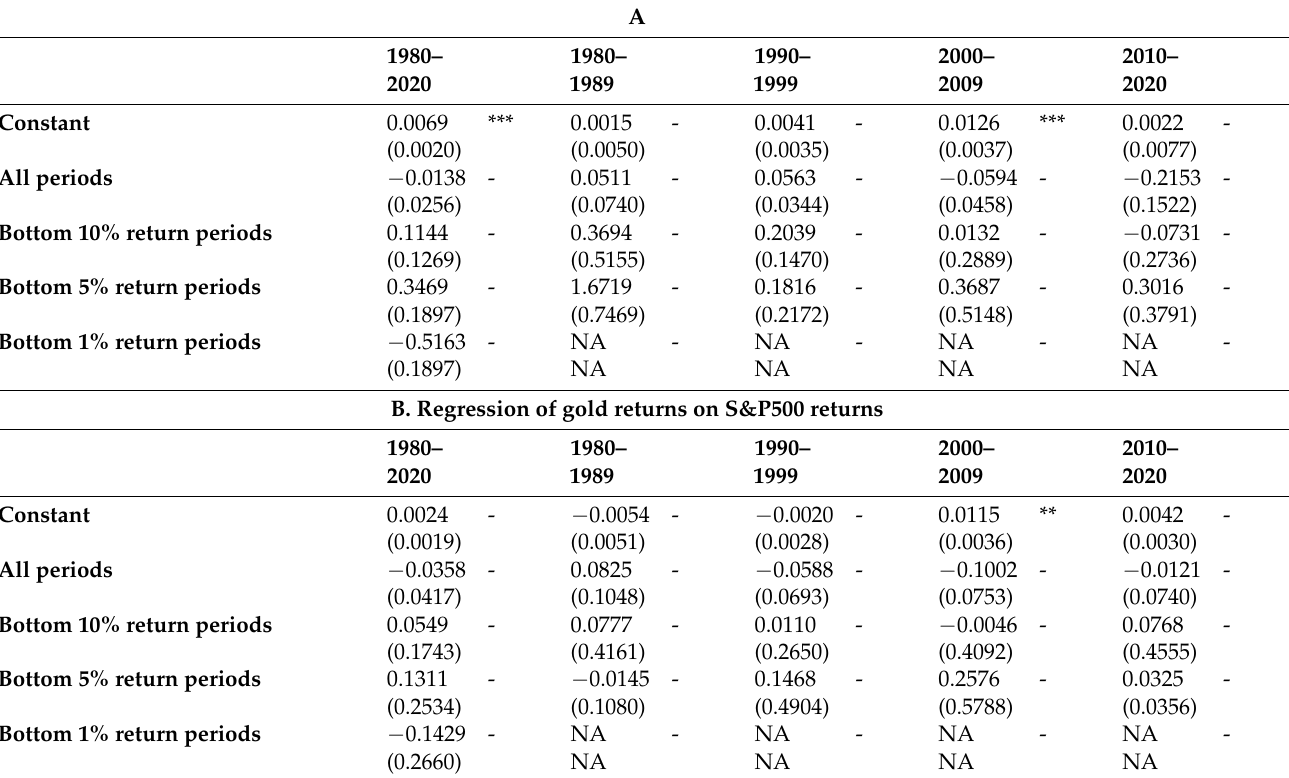
Table 4. Regression of gold returns on Sensex